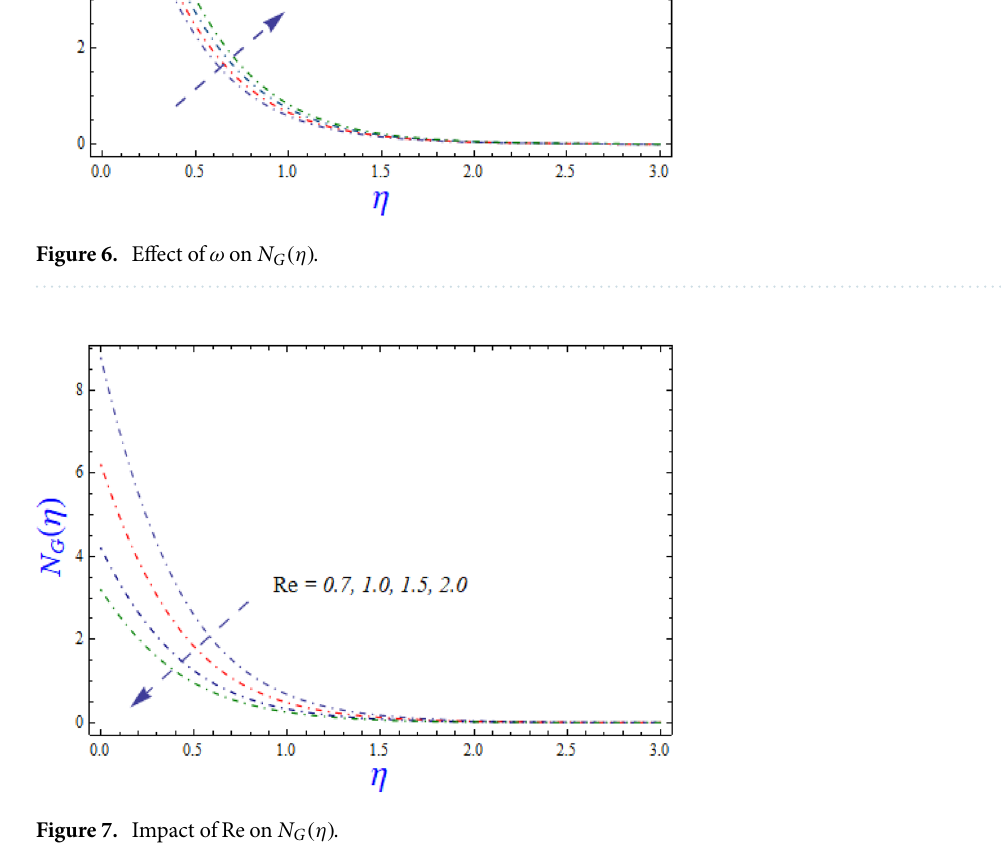
Figure 7. Impact of Re on N G (η)